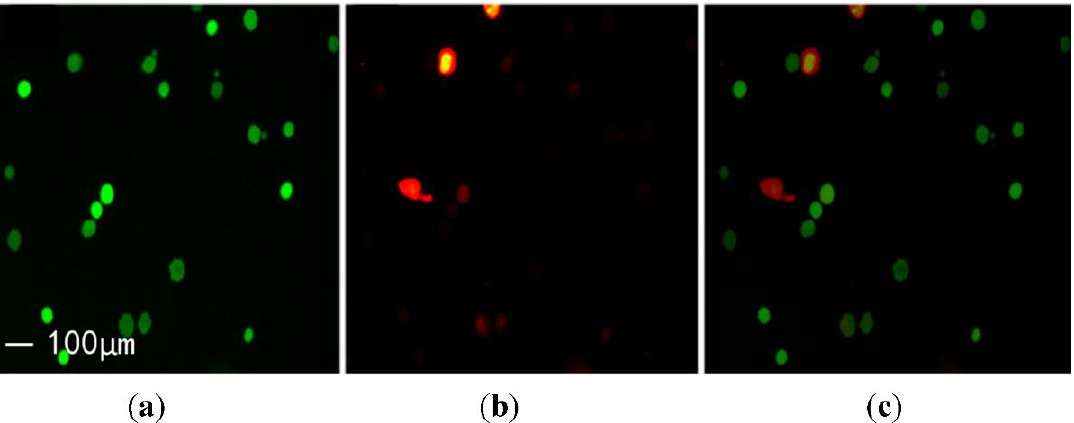
Figure 12. Results of 293T cell stained by FDA-PI: ( a ) live cells stained by FDA; ( b ) cells with damaged membranes stained by PI; ( c ) superposition of Figures ( a ) and ( b ).